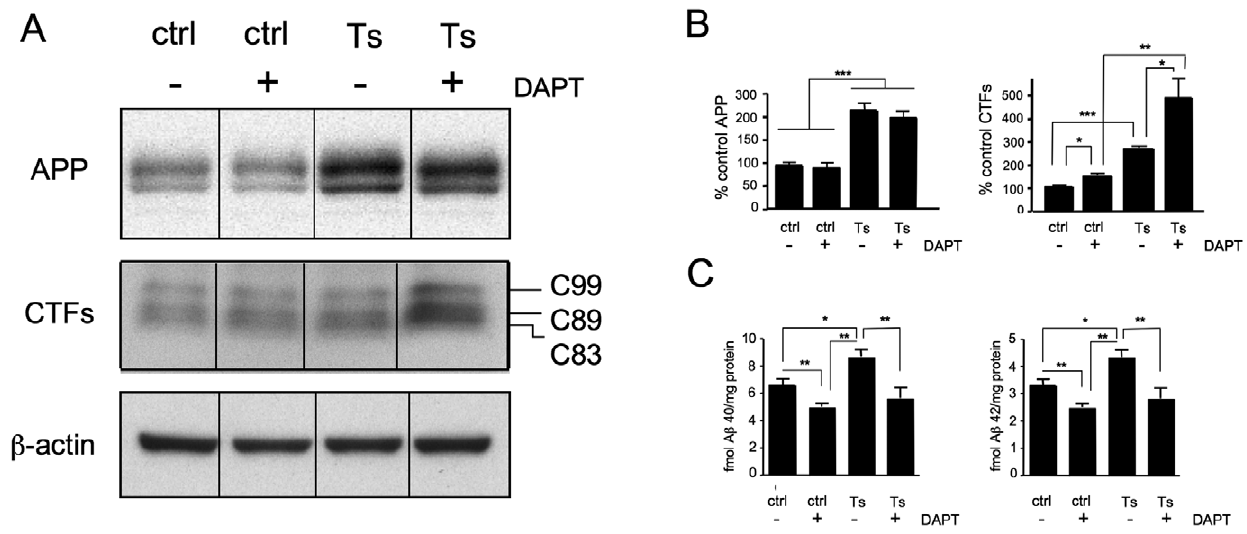
Figure 1. DAPT raises APP-CTF levels and lowers A b levels in brains of 4-month-old Ts65Dn mice. Four-month-old Ts65Dn mice and wild type colony mate controls were treated with vehicle or DAPT (100 mg/kg/day) for 4 days. (A) Representative western blots of APP, CTFs and b -actin fromcontrol (ctrl) and Ts65Dn (Ts) mice. (B) Left panel, quantification of APP (Students t-test, mean 6 s.e.m.,unpaired, two-tailed, n=8 per group). Ctrl + Vehicle vs. Ts + Vehicle,p=0.0003;Ctrl + DAPT vs. Ts + DAPT, p=0.0002; Ctrl + Vehicle vs. Ts + DAPT, p=0.0001; Ctrl + DAPTvs.Ts + Vehicle,p=0.0006.Rightpanel, combined (C99, C89 and C83) CTFs (all means differ significantly, n=8, 1-way ANOVA, p=0.0002; significant differences between individual pairs of mean calculated by Students t-test, mean 6 s.e.m., unpaired, two-tailed). (C) A b 40 and A b 42 quantification from control and Ts65Dn mice. Left panel, A b 40 (Students t-test, mean 6 s.e.m., unpaired, two-tailed, n=6 per group); Ctrl + Vehicle vs.Ts + Vehicle, p=0.0173;Ctrl + Vehicle vs. Ctrl + DAPT, p=0.0043;Ctrl + DAPT vs.Ts + Vehicle, p=0.0079; Ts + Vehicle vs. Ts + DAPT, p=0.0082. Right panel, A b 42 (Students t-test, mean 6 s.e.m., unpaired, two-tailed, n=6 per group); Ctrl + Vehicle vs. Ts + Vehicle, p=0.0169; Ctrl + DAPT vs. Ts + Vehicle, p=0.0003; Ts + Vehicle vs. Ts + DAPT, p=0.0052.